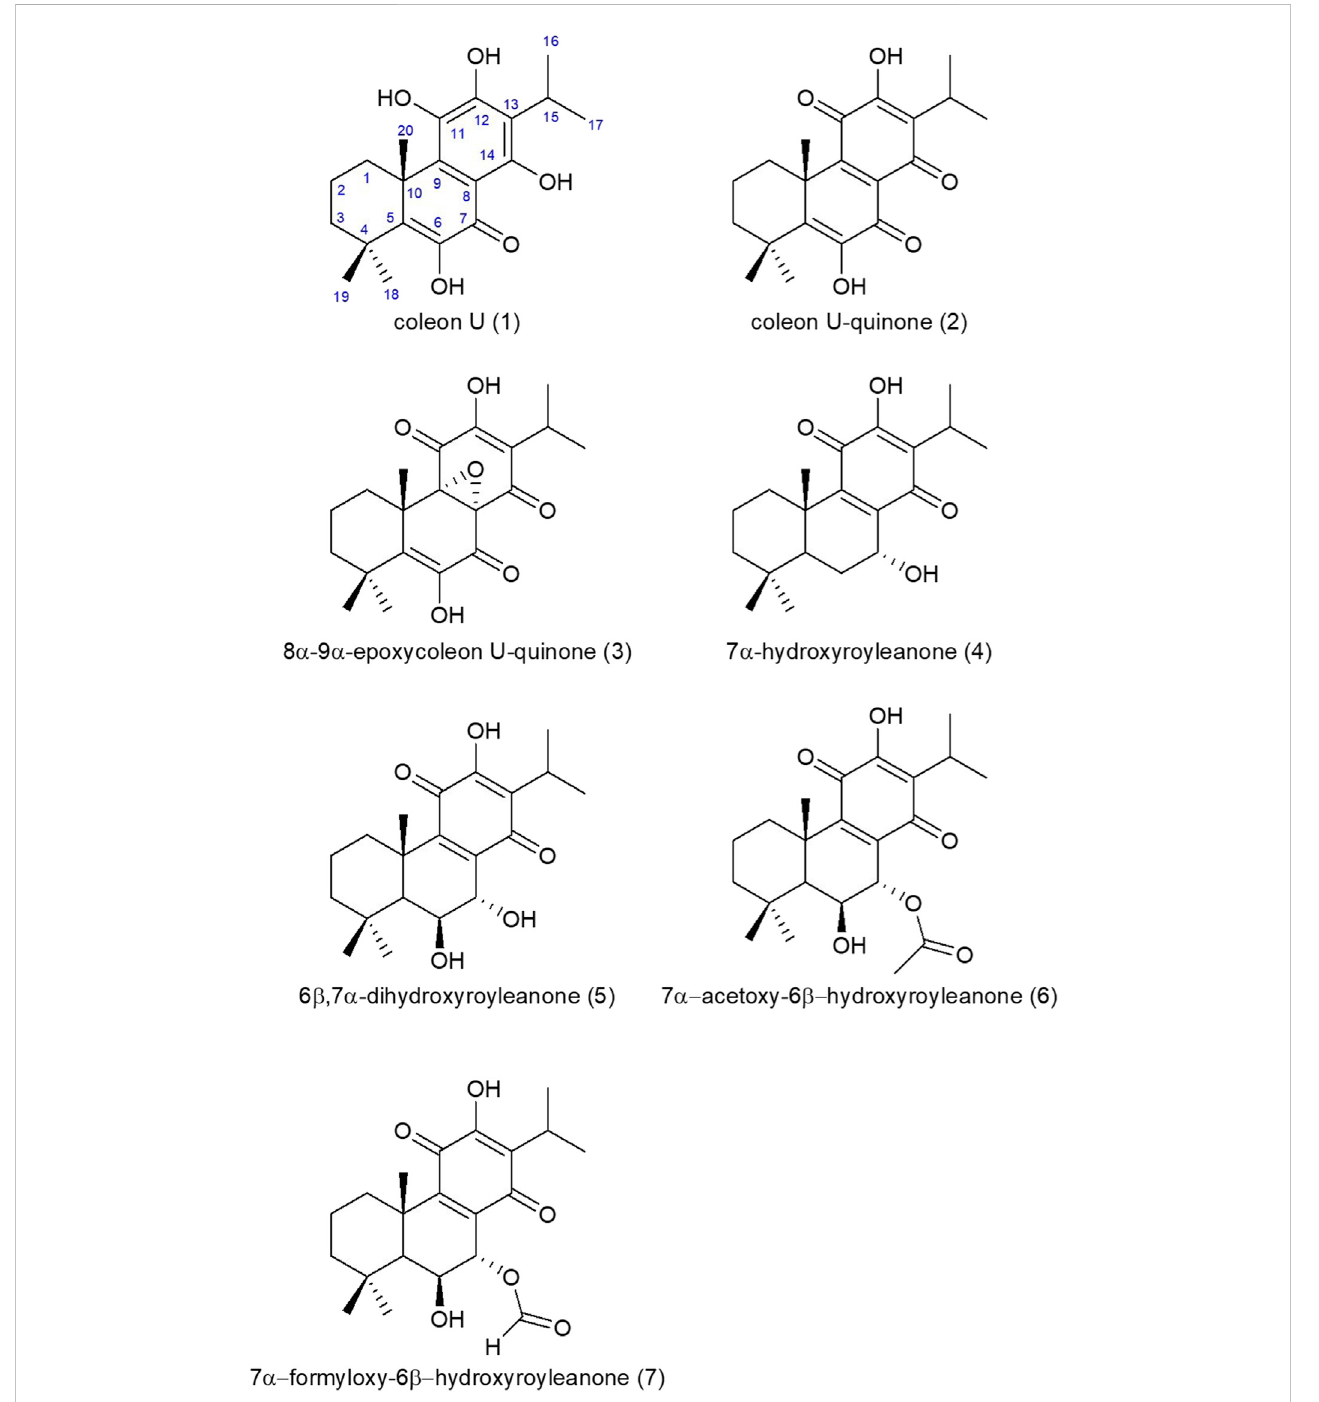
FIGURE 4 Chemical structures of molecules isolated from C. forsteri cyclohexane